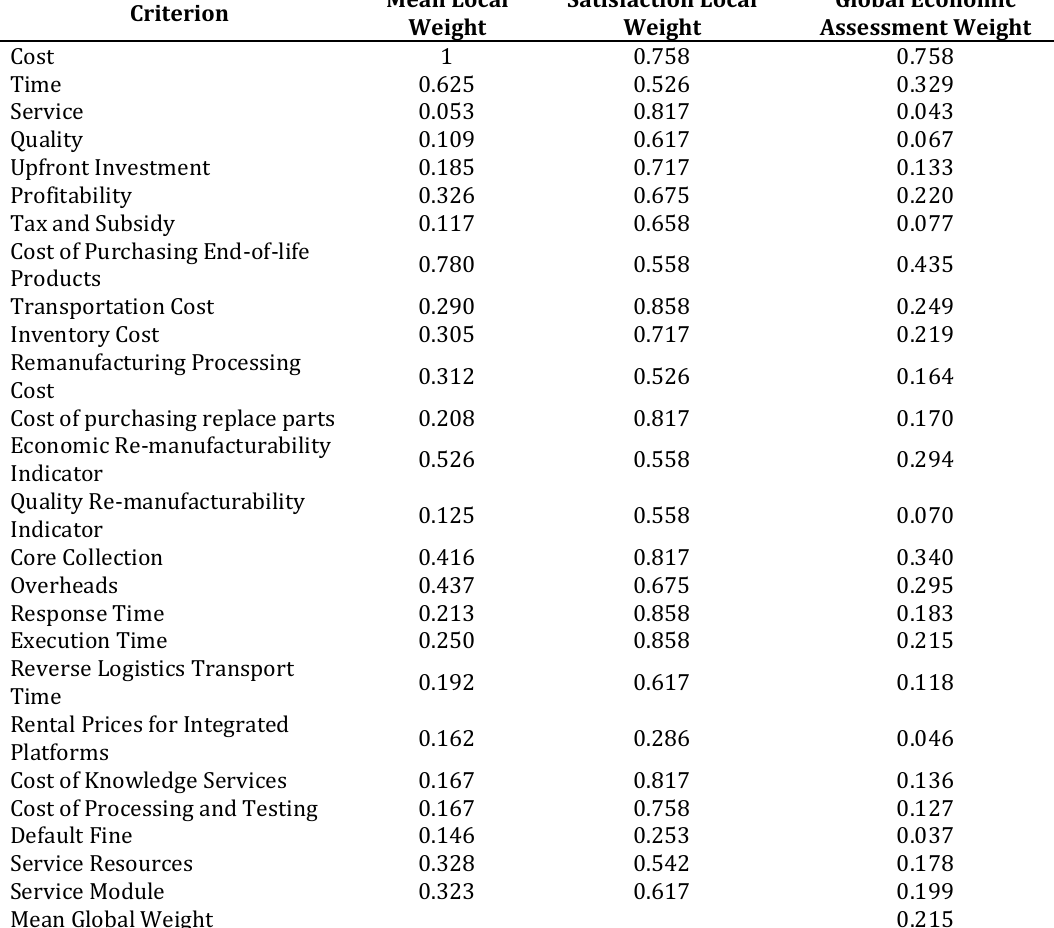
Table 2: Index weight and global weights of economic sub-sustainability assessment, micro- scale literature based